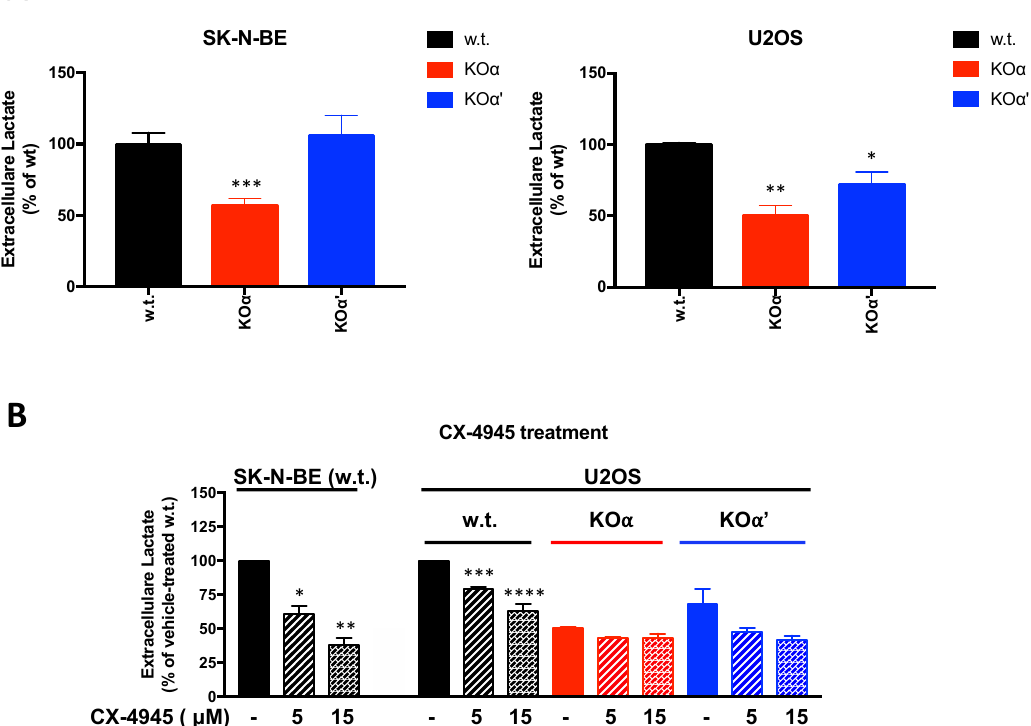
Figure 7. Lactate production in response to CK2 knock out or pharmacological inhibition. ( A ) The extracellular lactate secreted in the culture medium in 8 h by the indicated cells was analyzed by means of a luminescence assay. Values for each KO are the means ± SEM obtained with the different clones of the same KO. At least three independent experiments were performed, in duplicate. Significance refers to w.t. cells ( B ) Cells were analyzed for the extracellular lactate secreted in the culture medium in 6 h, in the absence or in the presence of the indicated concentrations of CX-4945. Three independent experiments were performed, in duplicate. Results (means ± SEM) are reported as % compared to the respective w.t. cells, in the absence of CX-4945. Significance refers to untreated control. (*) p < 0.05, (**) p < 0.01, (***) p < 0.001, (****) p <